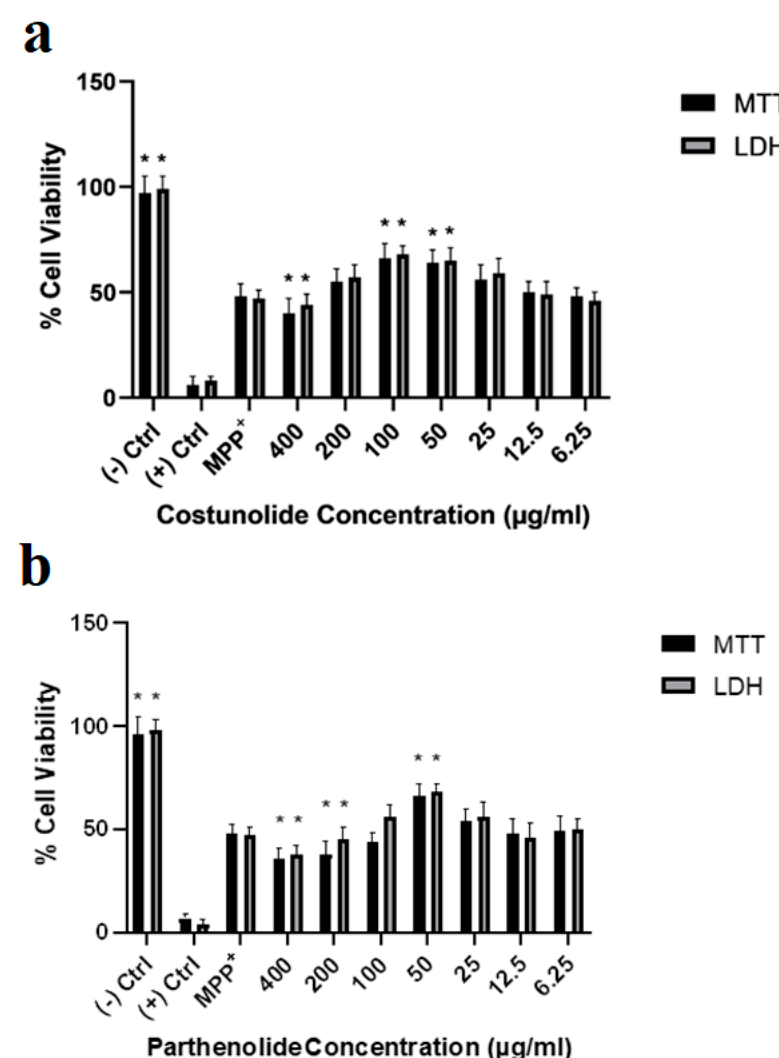
Figure 10. Cell viability analyses of SHSY-5Y cells treated with ( a )—costunolide and ( b )—parthen- olide in an experimental in vitro Parkinson’s Disease model for 24 h. ( − ) Ctrl: Negative control, MPP+: MPP+ treated cells and (+) Ctrl: Positive control (Triton-X). Statistical significance (increase) compared to MPP+ control was shown as * p < 0.05. (GraphPad Prism ® version 7.0, Two-way ANOVA and Tukey’s post hoc test were used to compare the means of different treatments to determine significant difference ( p <